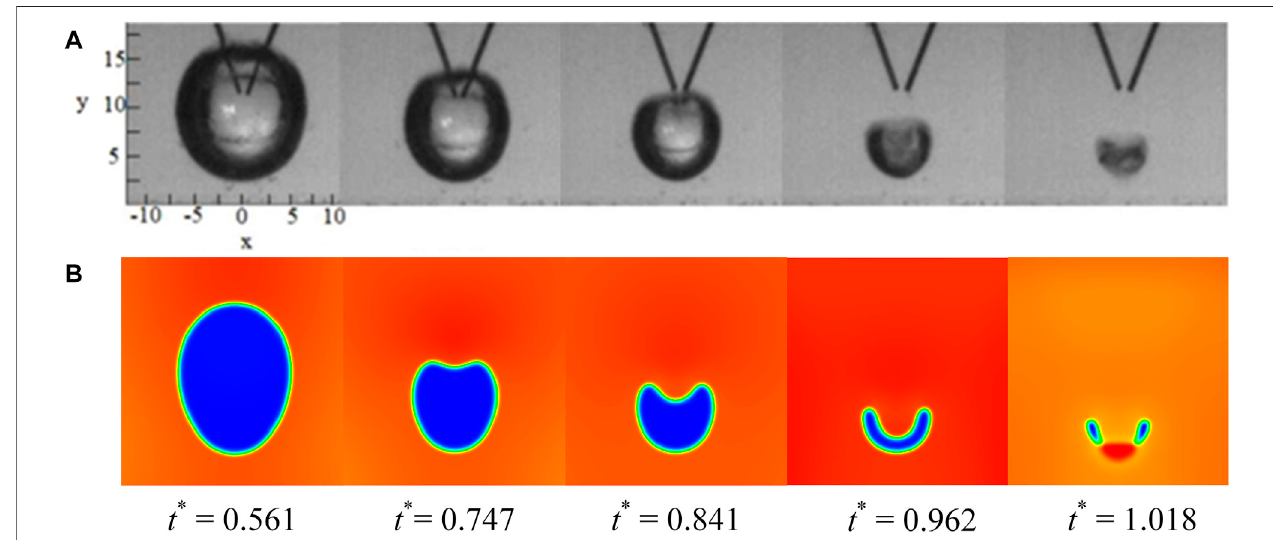
FIGURE5| Comparisonofthebubblepro fi lewithexperimental results( λ =1.2). (A) themorphologicalchangediagramofcavitationbubblenearsolidwallcollapse under high-voltage discharge-induced bubble experiment; (B) the phase diagram of cavitation bubble near solid wall collapse obtained by LBM simulation.